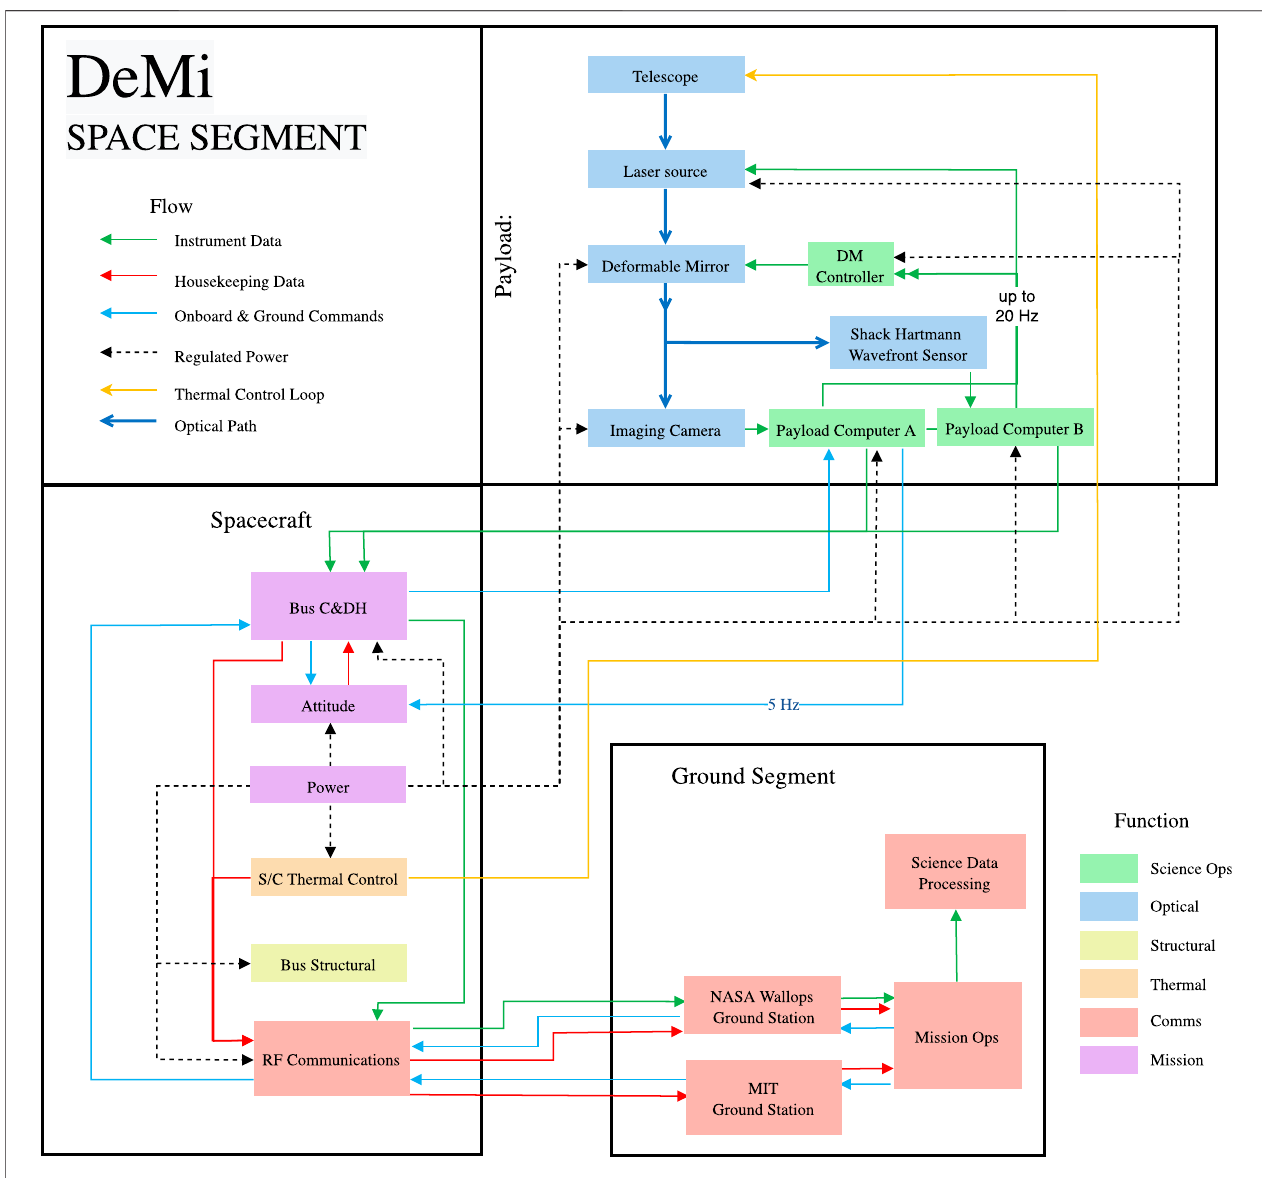
FIGURE 1 | DeMi mission level block diagram. The optical path ( Figure 2 ) is shown as thick blue arrows, all other paths are communications or power). Multiple electrical pathways, sensors, and payload computers to control the DM were implemented to maximize redundancy and improve the likelihood of mission success.